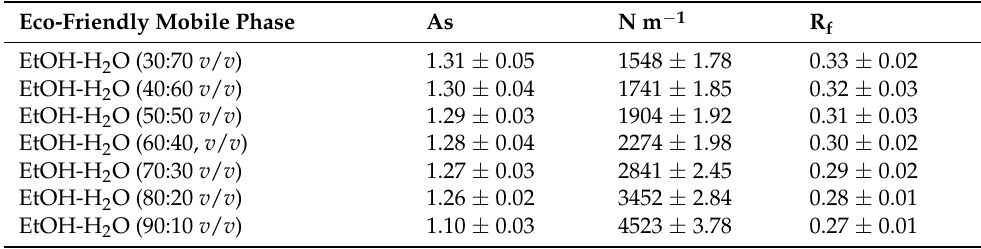
Figure 2. A typical, thin-layer chromatography (TLC) chromoplate of the standard CIN, formula- tions, and forced degradation samples derived from an eco-friendly EtOH-H 2 O (90:10 v / v ) mobile Table 1. The optimization of the eco-friendly mobile phases and measured chromatography parame- phase for the current approach. ters of cinnarizine (CIN) measurement for the present approach (mean ± SD; n = 3). Eco-Friendly Mobile Phase